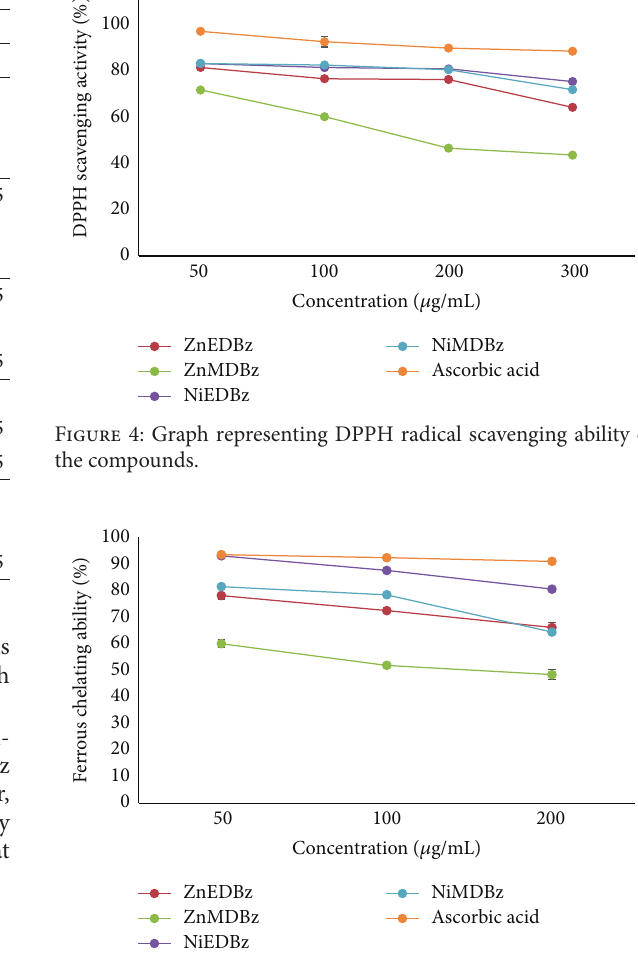
Figure 5: Graph representing % ferrous chelating ability of the